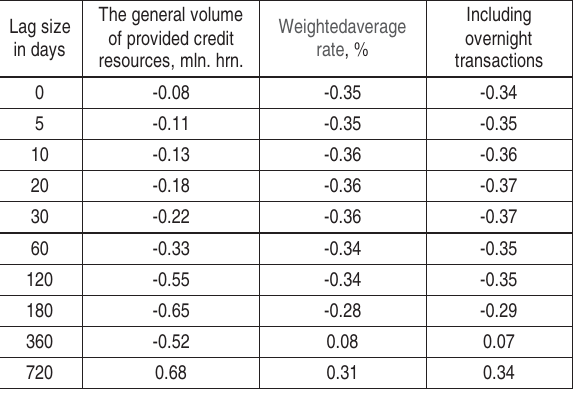
Table 6. Analysis of Ukrainian stock market reactions to the changes of crediting parameters of NBU (daily data) with the use of lags for UX index Lag size in